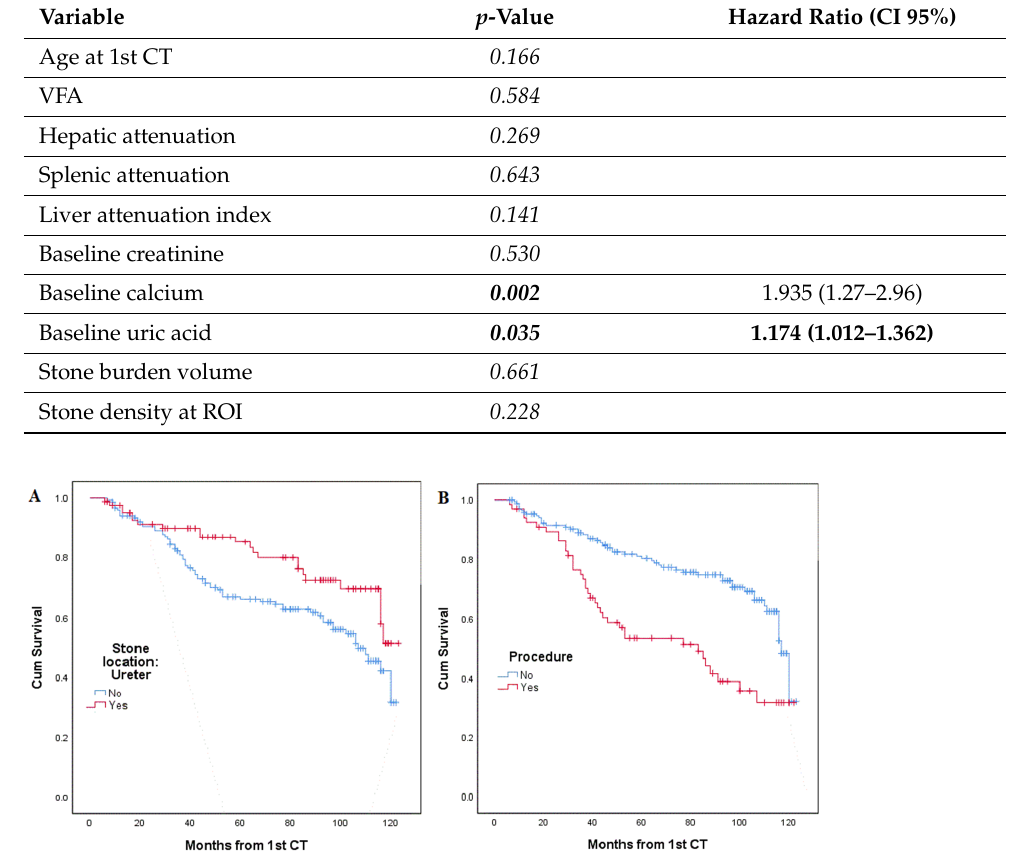
Figure 1. Kaplan–Meier analysis ( A ) stone in the ureter correlated to fewer recurrences, p = 0.019; ( B ) undergoing a procedure correlated to higher recurrence rates, p < 0.001. On multivariate analysis, the following parameters were associated with recurrence (Table 5): surgical intervention (Odds Ratio (OR) 3.07, p = 0.001), higher baseline calcium (OR 2.56, p = 0.011), and higher baseline uric acid (OR 1.30, p = 0.021), wherein the latter two are separate risk factors. ROC curves for calcium and uric acid are presented in Figure